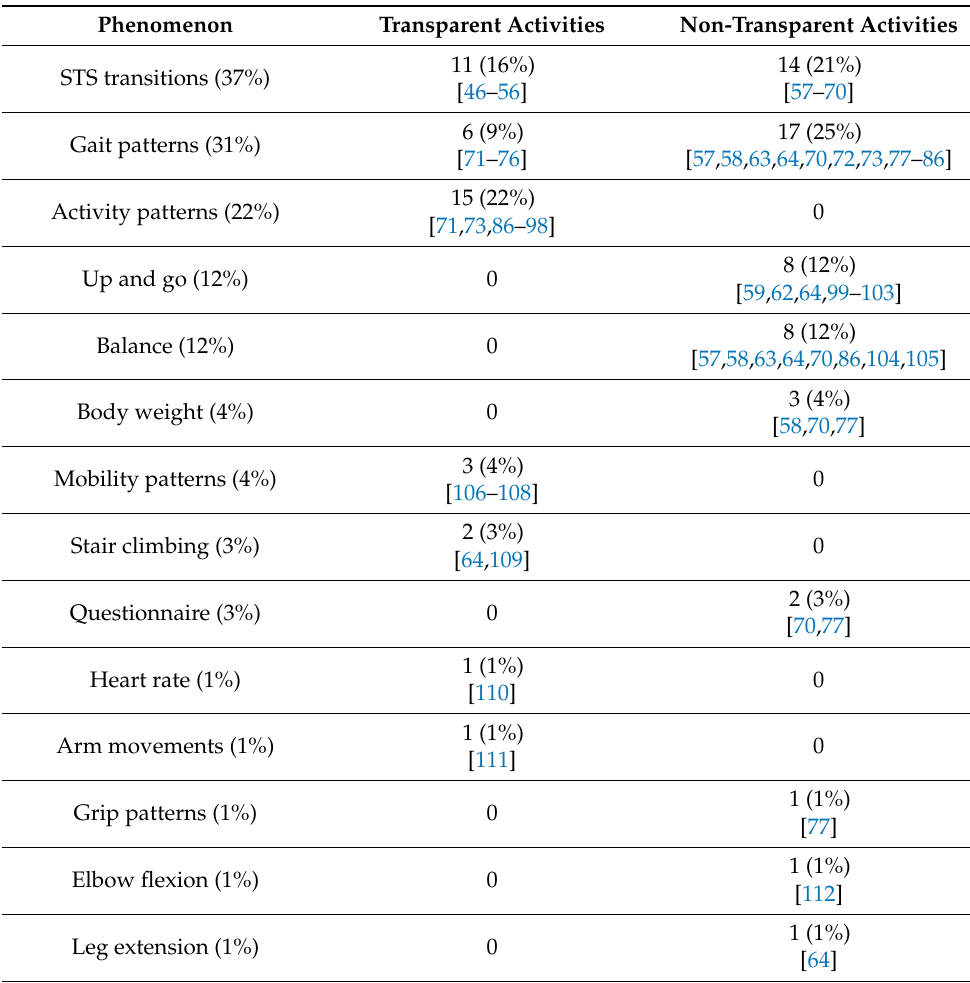
Table 1. Phenomena that have been quantified by the sensors included in the present review (left column) together with the number of studies complying (middle column) and not complying (right column) with transparency requirements. The figures in square brackets are the citations for the corresponding studies. The figures in brackets represent the percentage with respect to all 67 studies in the